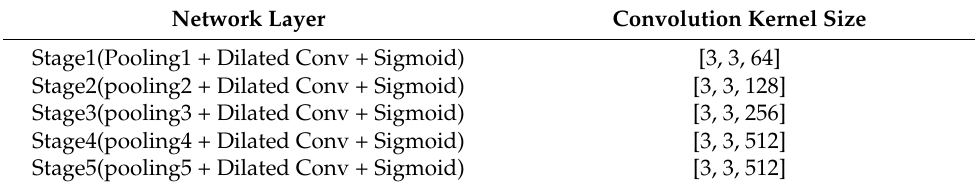
Table 1. Parameters of each stage in the improved HED network.